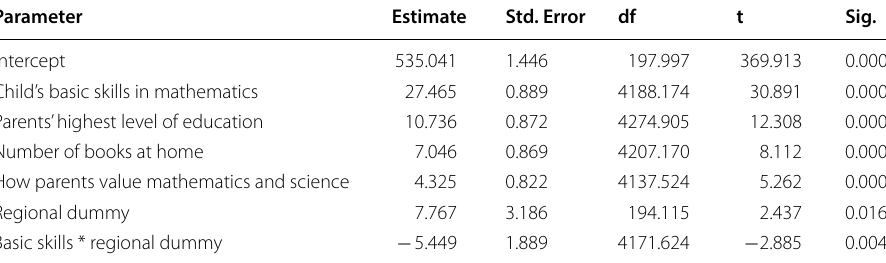
Table 3 Significance of different parameters of “Model 2” Parameter Estimate Std. Error df t